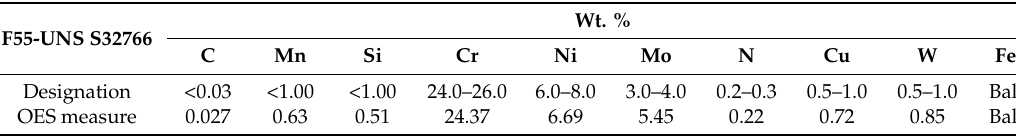
Table 1. UNS S32760 super duplex stainless steel chemical composition (expressed in wt.%), as designed by standards and measured via optical emission spectroscopy (OES).